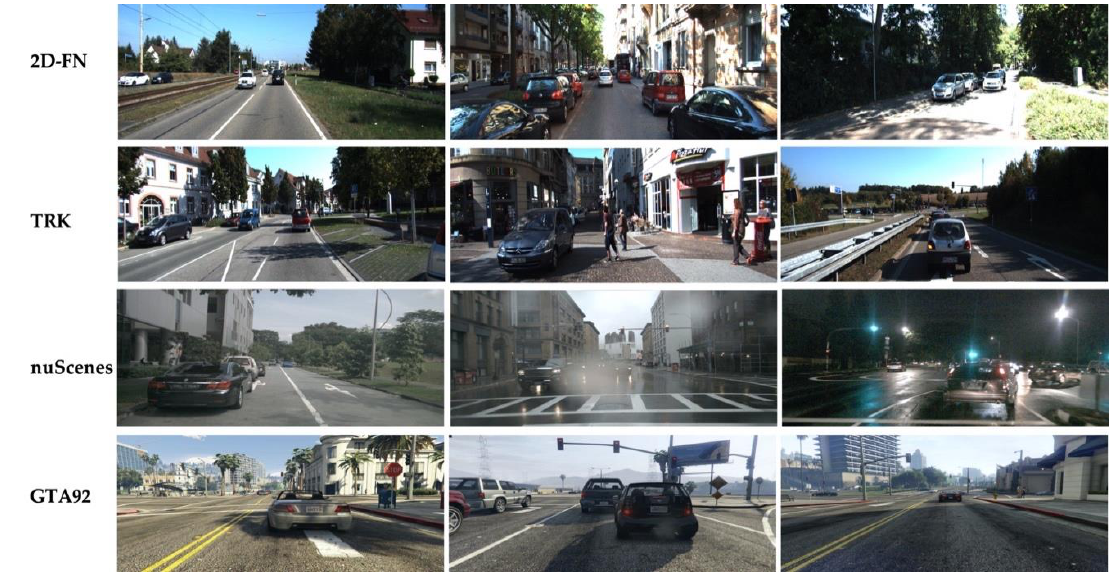
Figure 6. Samples from the test datasets we adopted. While the 2D-FN and the TRK share similar weather conditions and driving scenes, the nuScenes and the GTA92 dataset both show distinct domain disparities caused by different driving conditions and driving scenes.